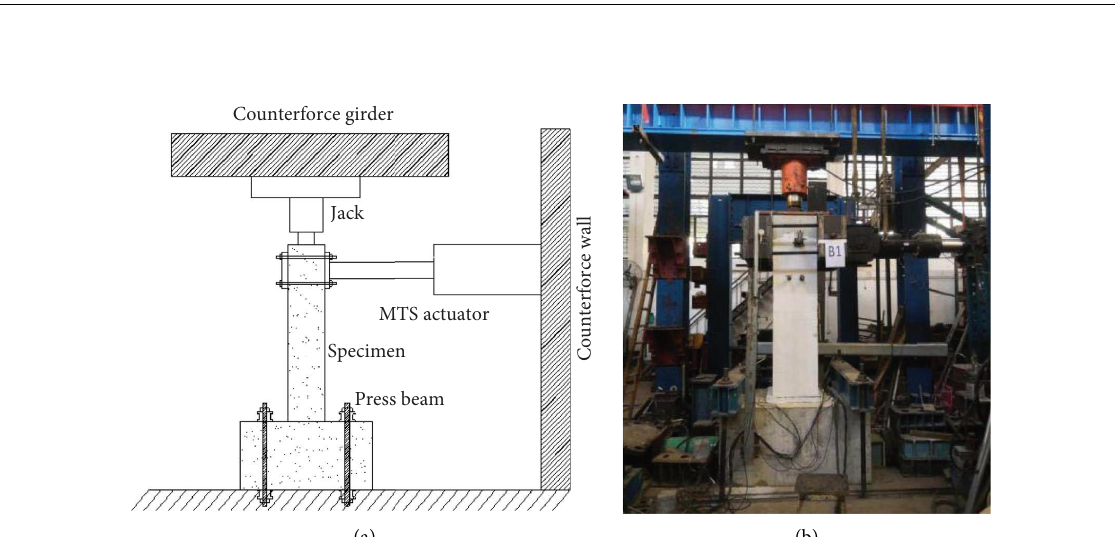
Figure 4: Loading device. (a) Schematic diagram of the loading device. (b) Photograph of the loading